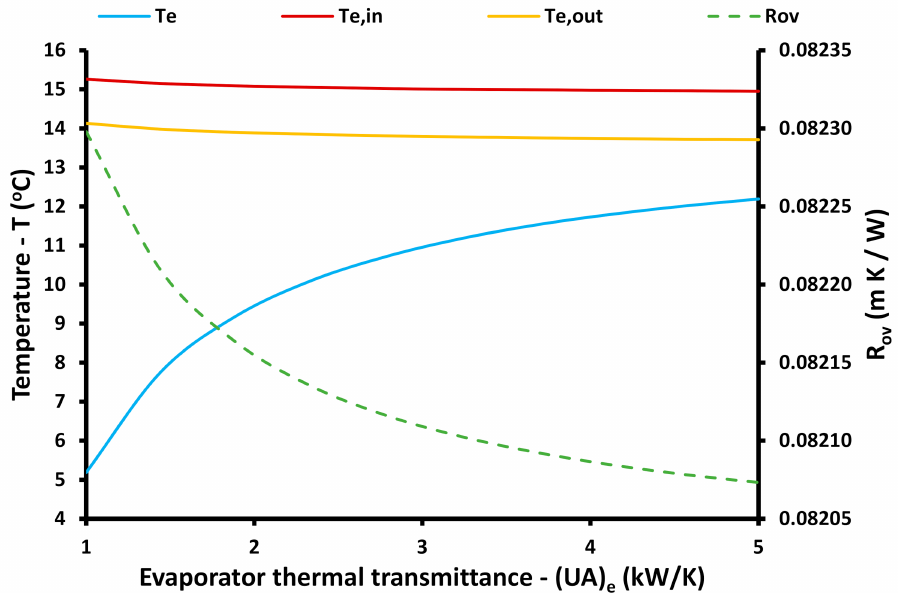
Figure 13. The impact of the evaporator thermal transmittance in the evaporator on the evaporator temperature levels and on the overall